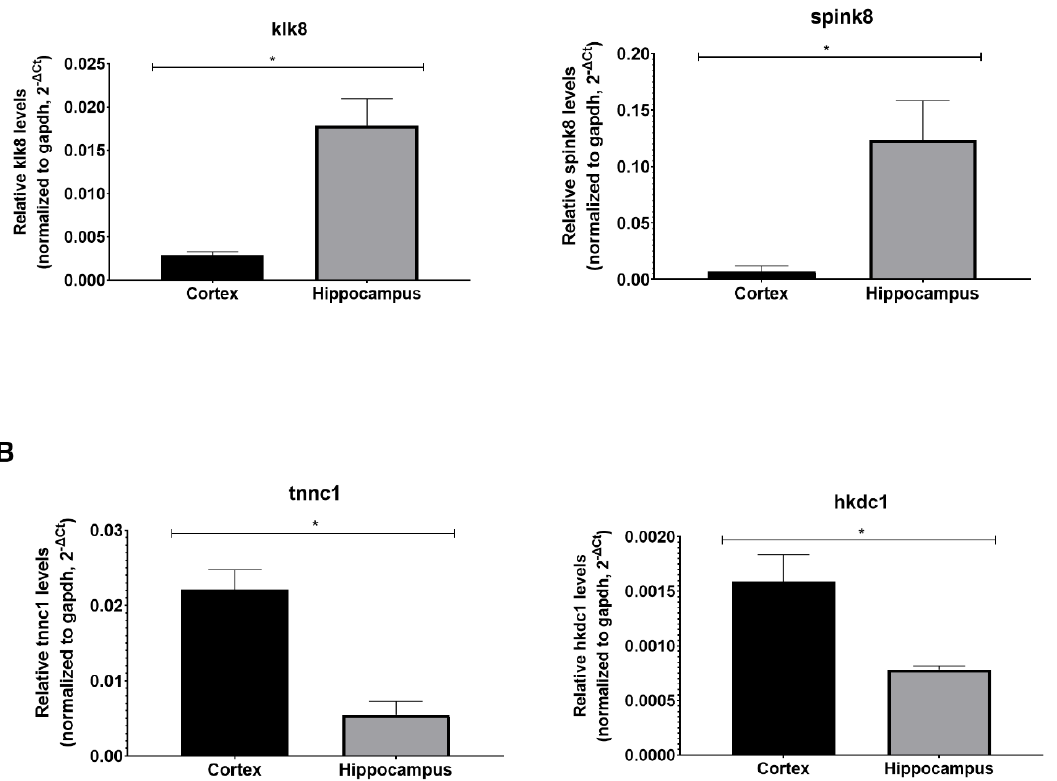
Figure 1. Markers of the two brain regions: the cortex and the hippocampus. mRNA levels of the brain region markers were measured in the dissected cortex and hippocampus through real-time PCR. Results are the means ± SEM from three lots of cerebral structures from three mice and the PCR performed in duplicate for each single preparation. Statistical comparisons: * p < 0.05.